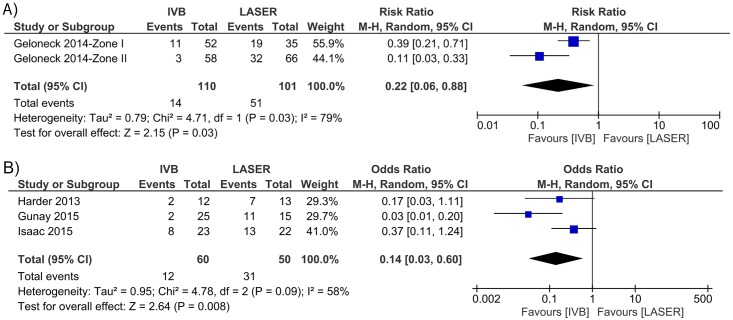
Forest plots of the prevalence of high myopia following IVB and laser treatments.A) Pooled estimates for risk ratios and 95% CI in events of high myopia occurred following two treatments in RCTs. B) Pooled estimates for odds ratios and 95% CI in events of high myopia occurred following two treatments in NRSs. The black diamond symbol on the bottom row shows the estimated true effect size.